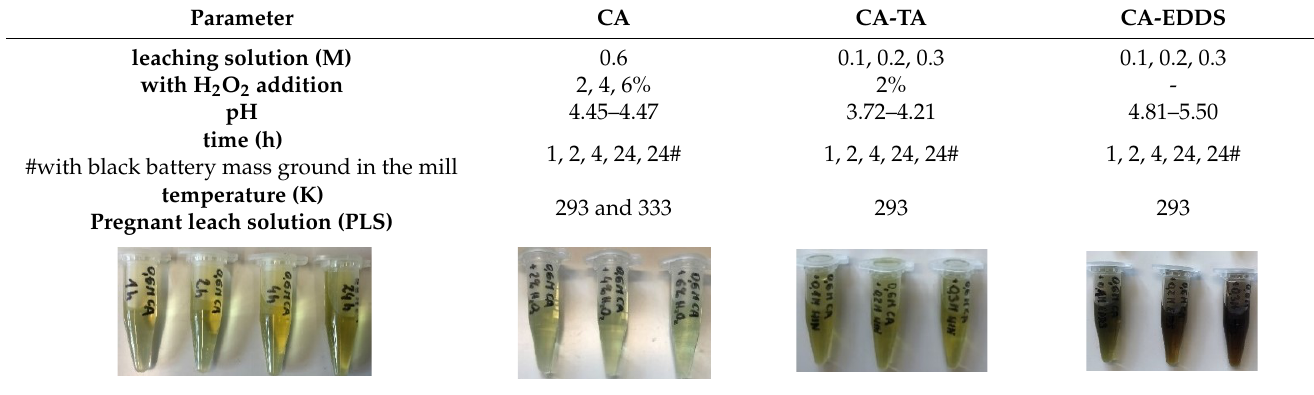
Table 2. Parameters of black battery mass leaching using CA, TA, and